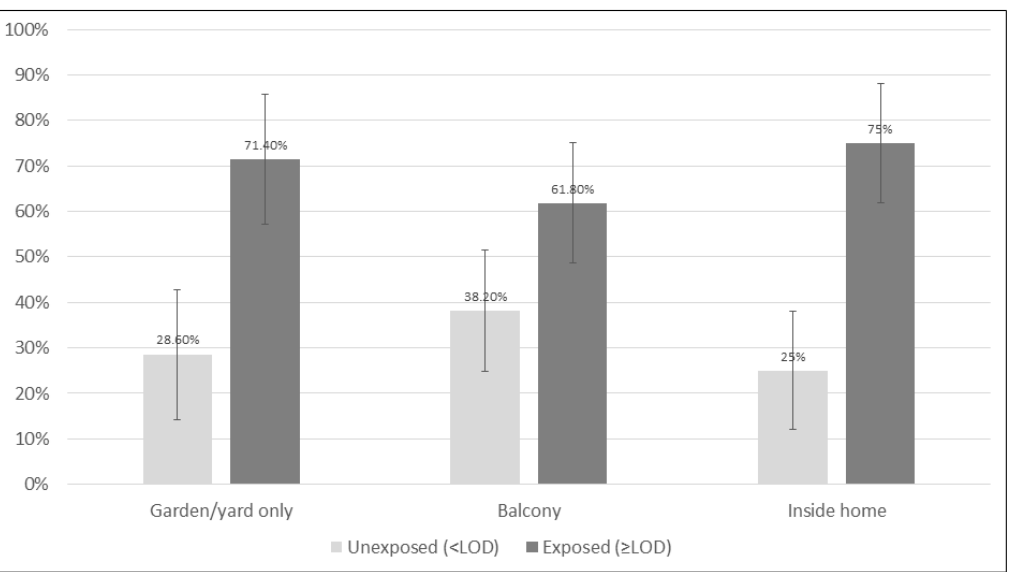
Figure 1. The proportion of children exposed to tobacco smoke as determined by hair nicotine (based on the limit of detection (LOD) of nicotine) by the usual location of smoking. Error bars denote a 95% confidence interval.